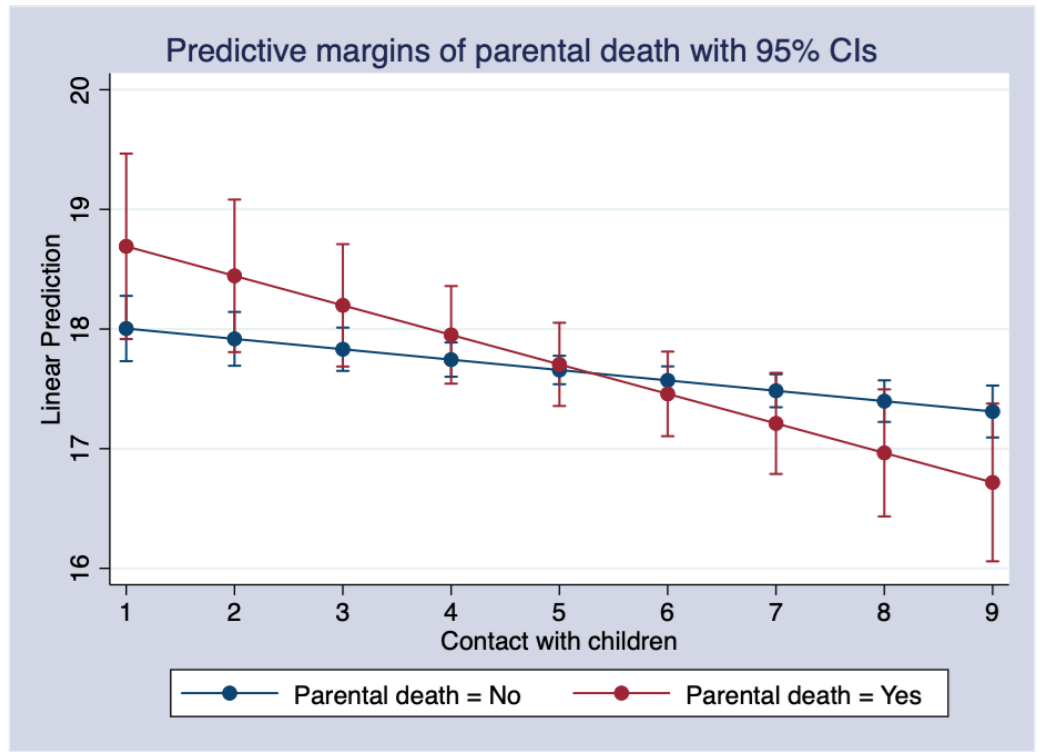
Figure A2. The marginal effects of contact with children on depression and parental death.